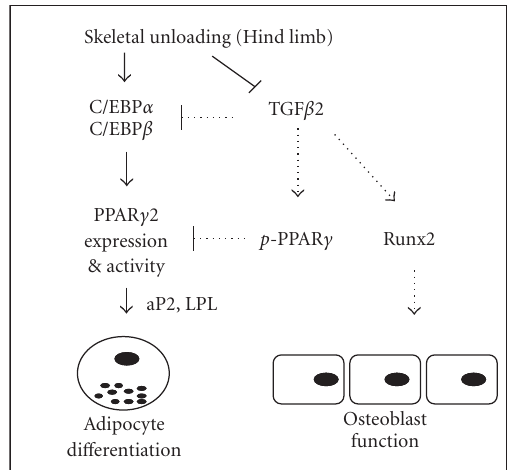
Figure 2: Skeletal unloading decreases TGF- β expression and ac- tivates the expression of C/EBP α , C/EBP β , and PPAR γ 2, result- ing in activation of adipocyte gene expression such as adipocytic di ff erentiation-related genes adipocyte binding protein (aP2) and lipoprotein lipase (LPL) in bone marrow stromal cells. Exogenous TGF- β 2 (dotted lines) reduces C/EBP α , C/EBP β , and PPAR γ ex- pressions, induces PPAR γ phosphorylation ( p -PPAR γ ), and in- creases Runx2 expression, resulting in decreased adipogenesis, in- creased osteoblast function, and prevention of bone